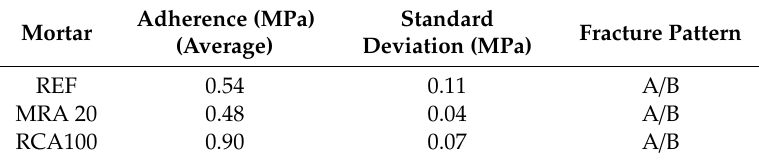
Table 8. Adherence strength of the mortars tested.